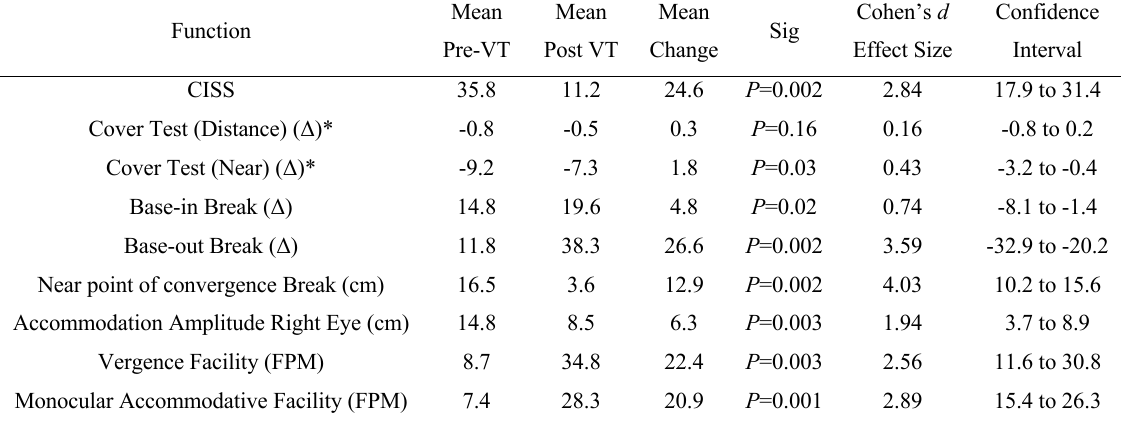
4° Symmetrical Convergence